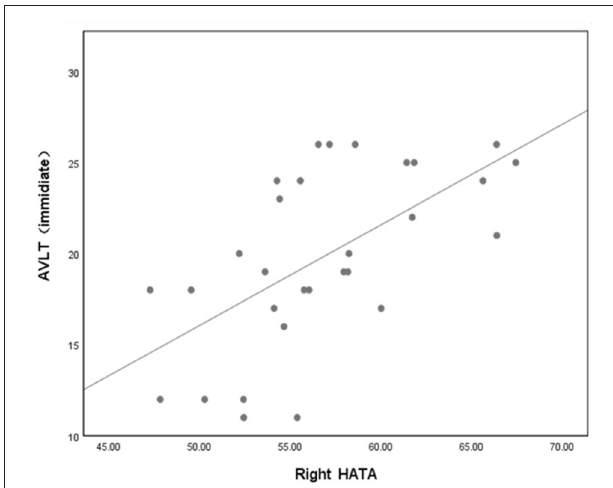
FIGURE 4 | Volume of right HATA was correlated with AVLT (immediate) scores ( P = 0.03, r = 0.427). Adjusted age, sex, education and eTIV. AVLT, auditory verbal learning test; HATA, hippocampus amygdala transition